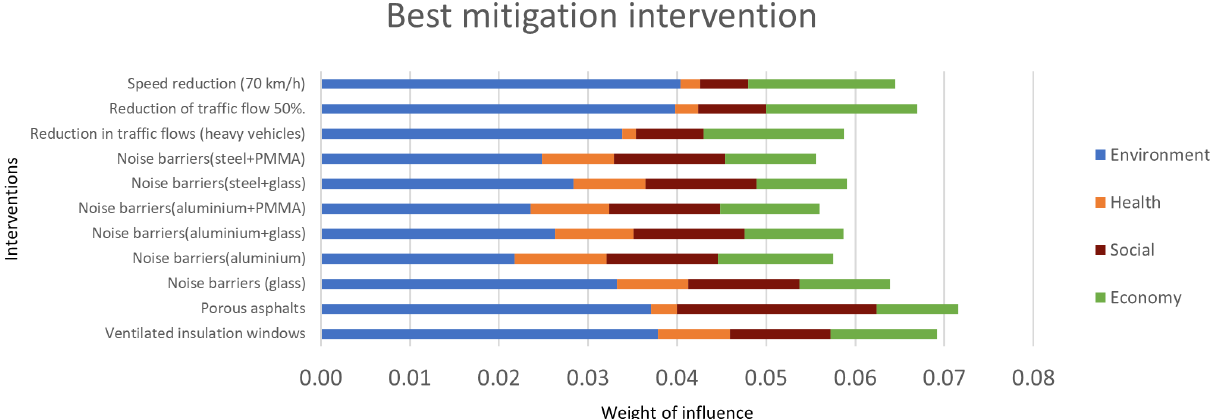
Figure 13: Analysis results for the nighttime